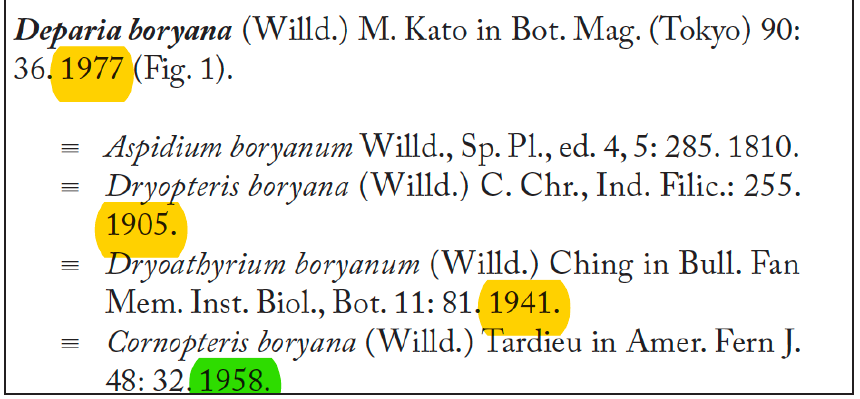
Fig. 9. In this example the references in yellow are not provided in the bibliographic section, but the the one in green is, because it has been formally mentioned elsewhere in the article as a reference (Rakotondrainibe & Jouy 2016).